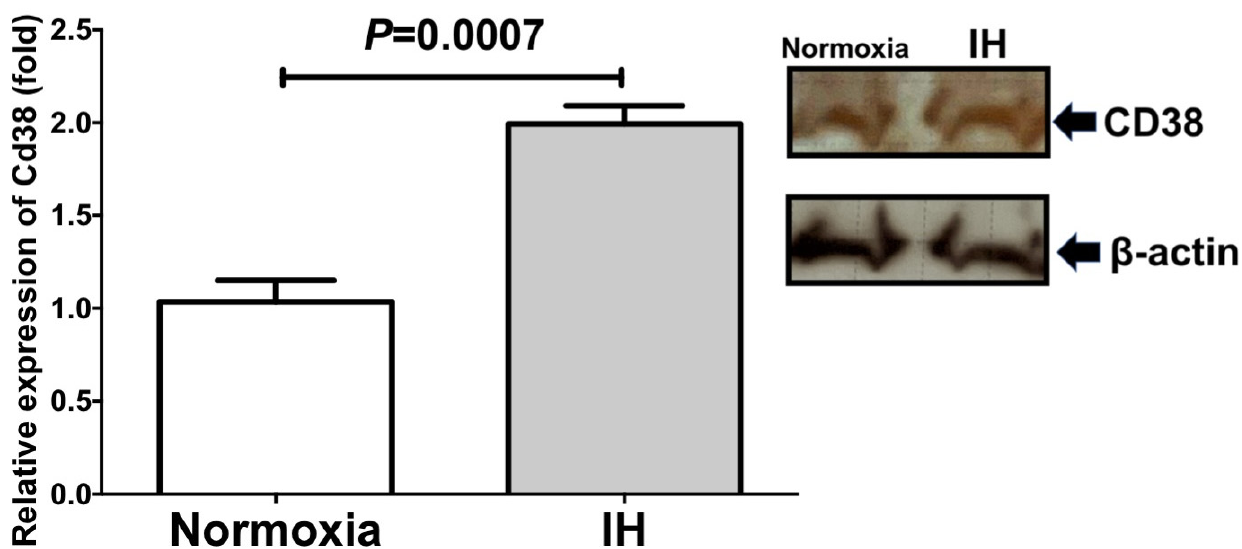
Figure 4. Relative protein expression of Cd38 in the As4.1 JG cells subjected to IH. A representative immunoblot is shown in right panel. The relative expression of the Cd38 is arbitrarily presented. The Cd38 band densities were quantified using an image analysis and then normalized to β -actin, as measured in the same blot. Each bar represents the mean values of four independent experiments. The results are expressed as the mean ± SE in arbitrary units.